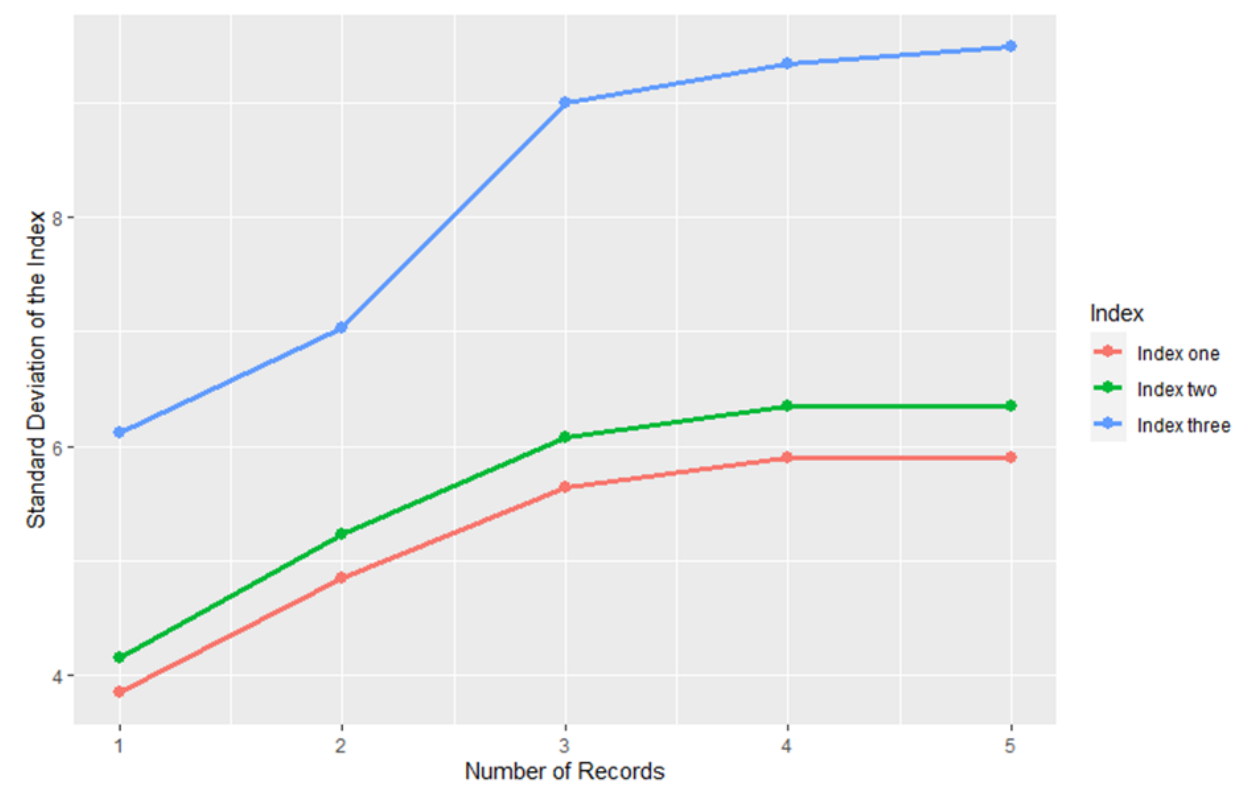
Figure 2. Effects of addition records on the standard deviation of the index. See Table 4 for a description of the index scenarios.